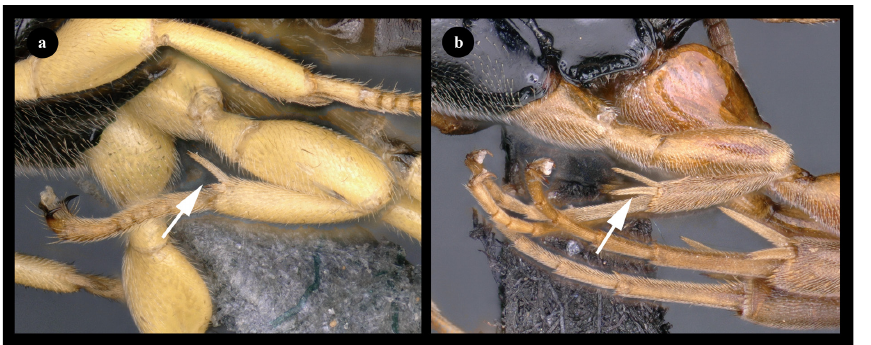
Fig. 11. a . Exochus sp., mid leg. b . Hypsicera , mid leg. Arrow in Fig. 11a points to mid tibia with shorter outer spur (compared to subequal midtibial spurs in Fig. 11b).